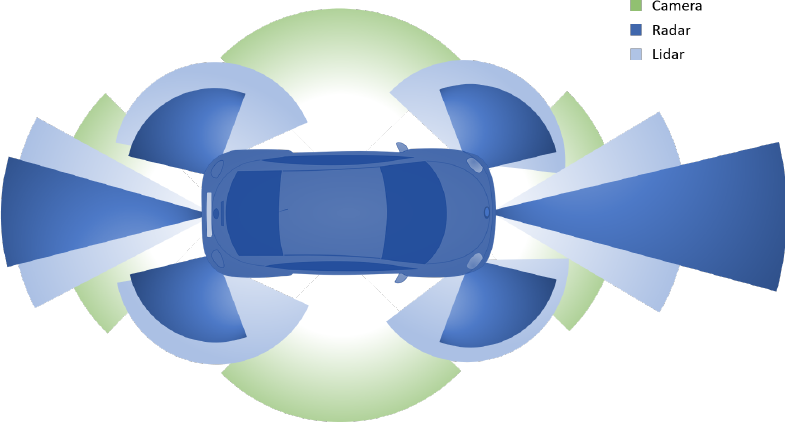
Figure 3. Example sensor setup for a self-driving